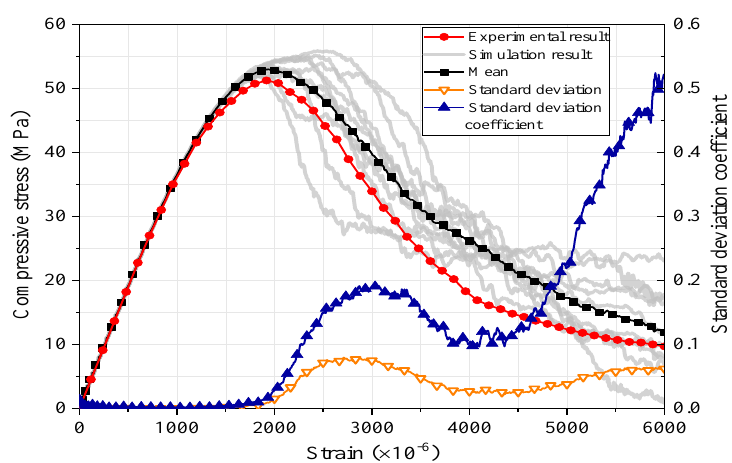
Figure 12. Statistical characteristic of global stress-strain curve under compression.